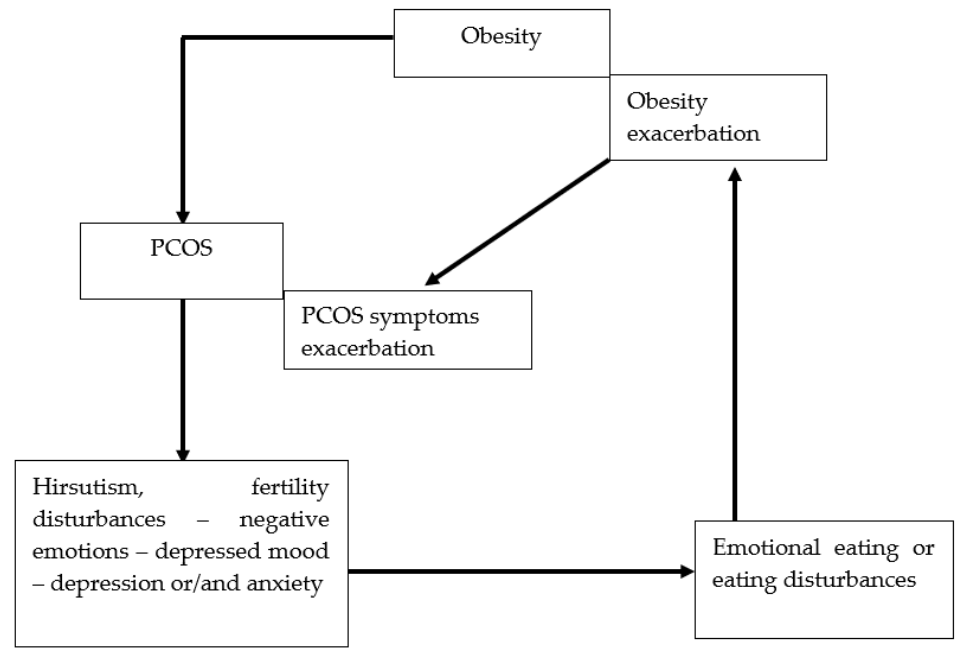
Figure 1. Vicious circle between EE or EDs and obesity and PCOS. EE: emotional eating; EDs: eating disorders; PCOS: polycystic ovary syndrome.